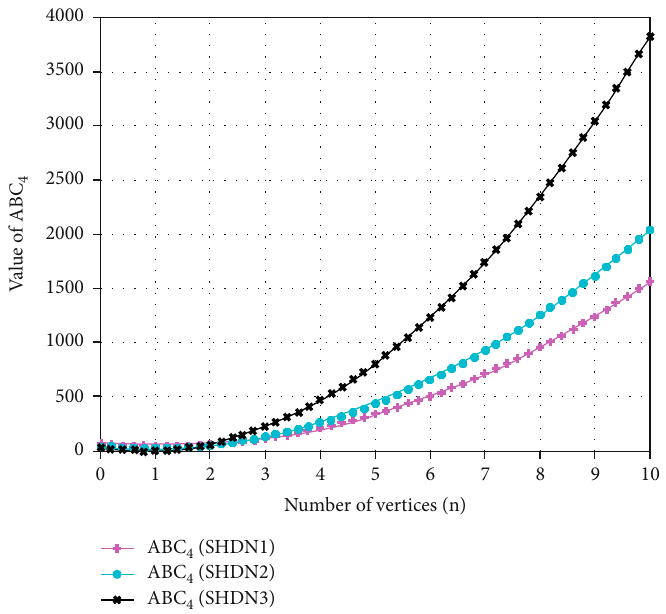
Figure 17: Comparison of Γ